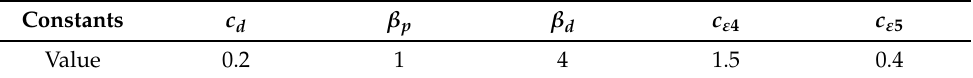
Table 1. Constant parameters for tree modelling.